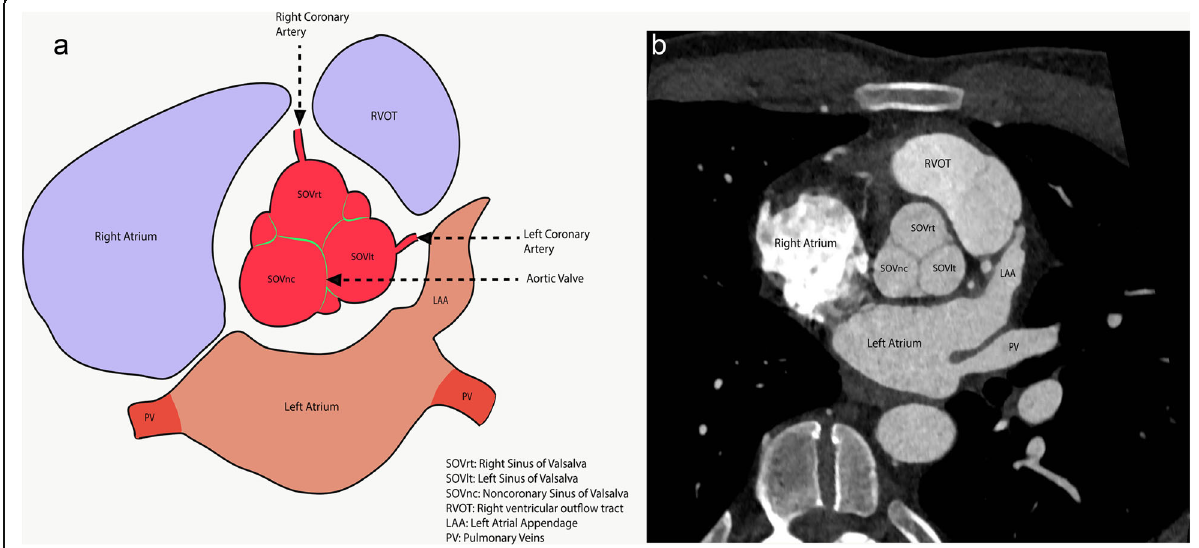
Fig. 4 An illustration ( a ) and a CTA short axis image ( b ) through the sinuses of Valsalva highlighting the nomenclature and